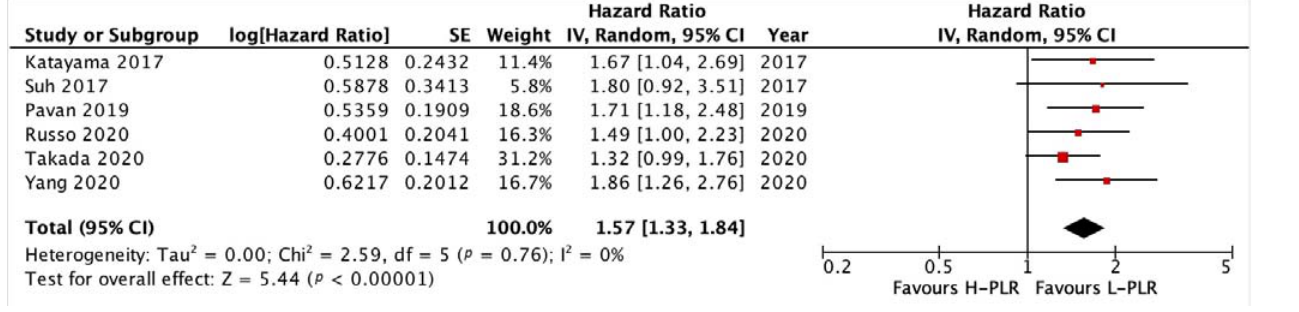
Figure 5. Forest plot H-PLR versus L-PLR to PFS in patients treated with immunotherapy. Red dots represent study weights; the bivalve represent the overall effect.